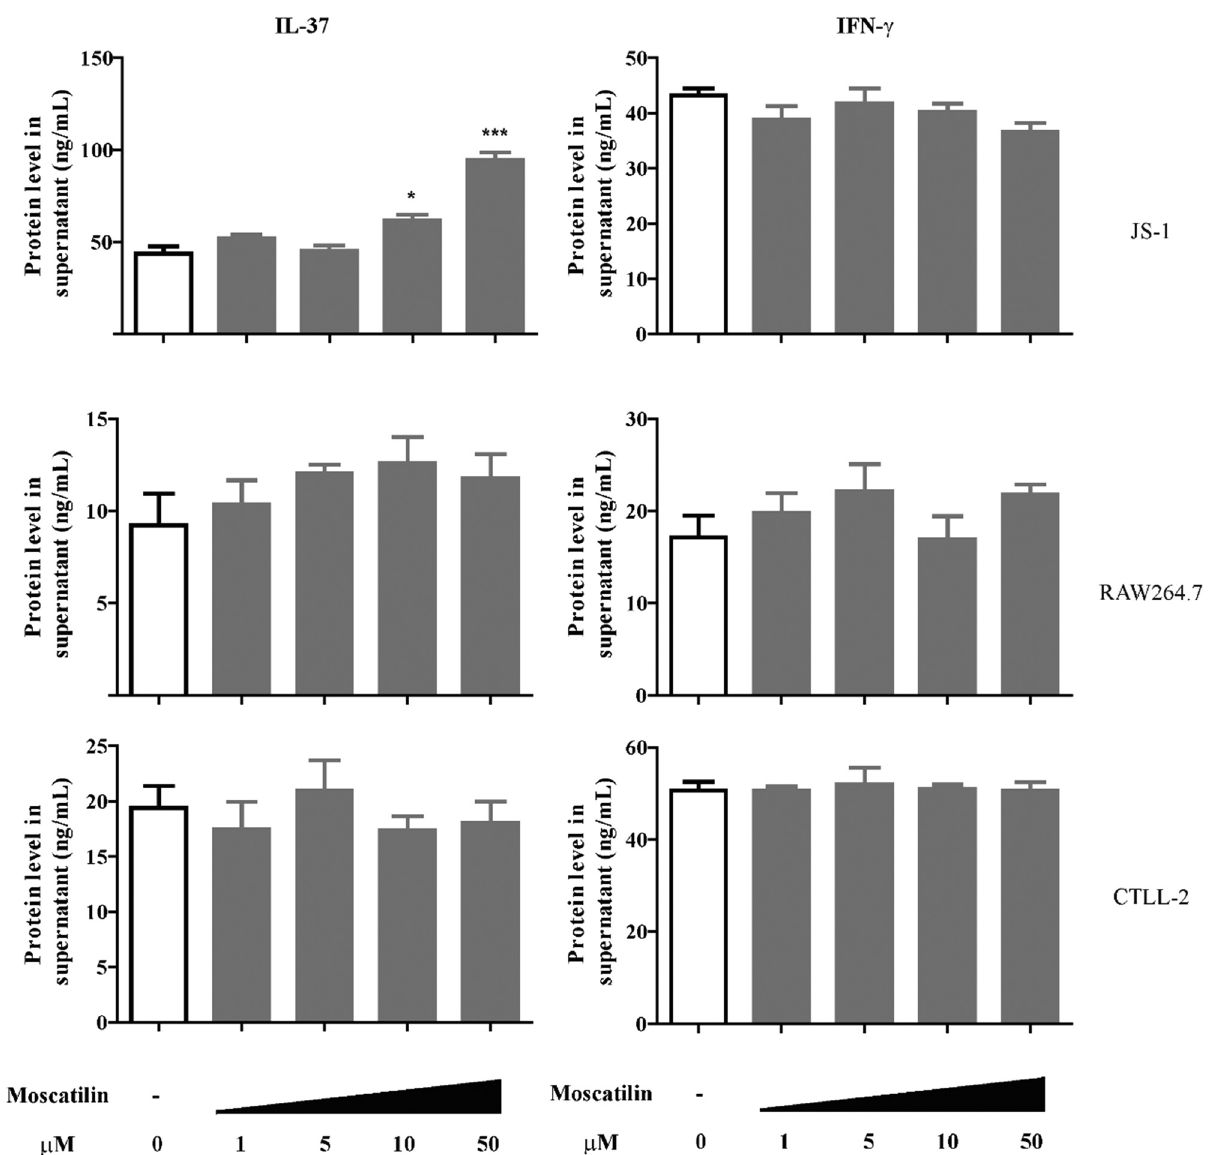
Figure A4: E ff ects of moscatilin treatment on IL - 37 and IFN - γ protein level in the cells in vitro . Hepatic stellate cell line ( JS - 1 ) , macrophage cell line ( RAW264.7 ) and T cell line ( CTLL - 2 ) were treated with di ff erent dose of moscatilin for 48 hours and the protein level of IL - 37 ( left ) and IFN - γ ( right ) in the supernatant was detected by ELISA. Each group contained 5 samples and * indicated p value less than 0.05, *** indicated p value less than 0.001 compared to control